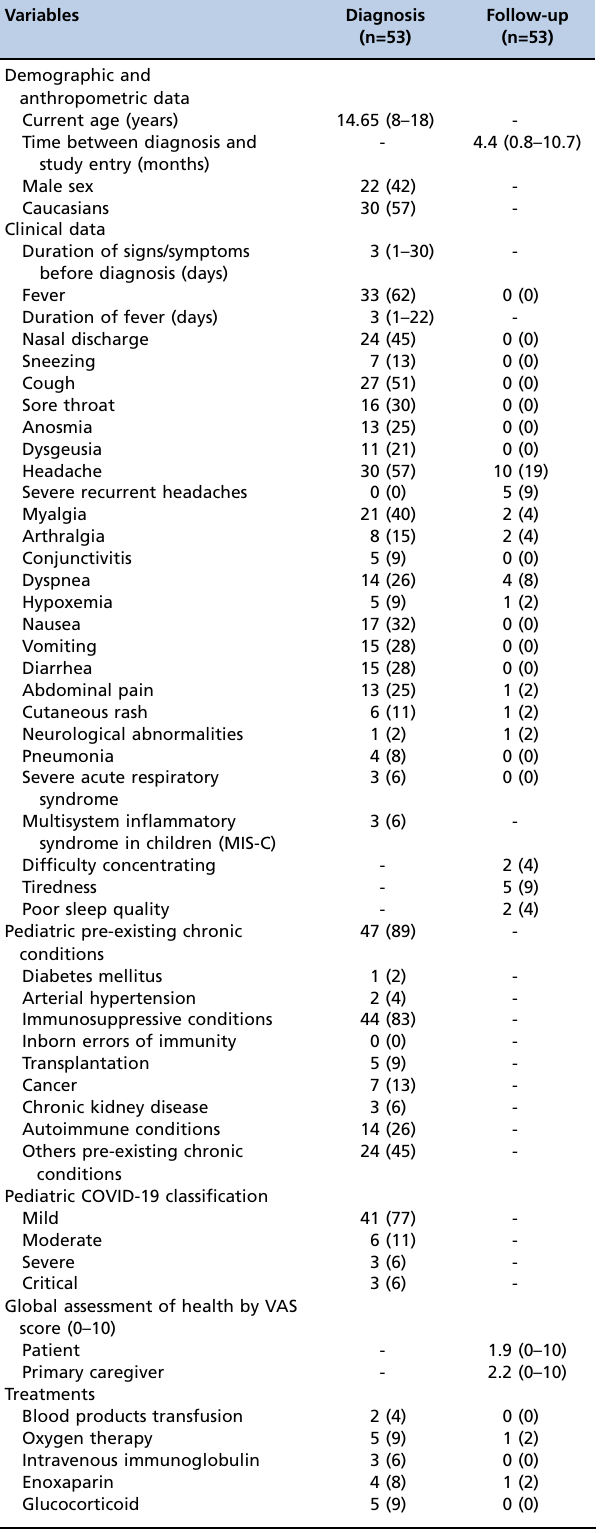
Table 1 - Demographic, anthropometric, and clinical data, and treatments and outcomes in pediatric laboratory-confirmed coronavirus disease (COVID-19) at diagnosis and longitudinal follow-up